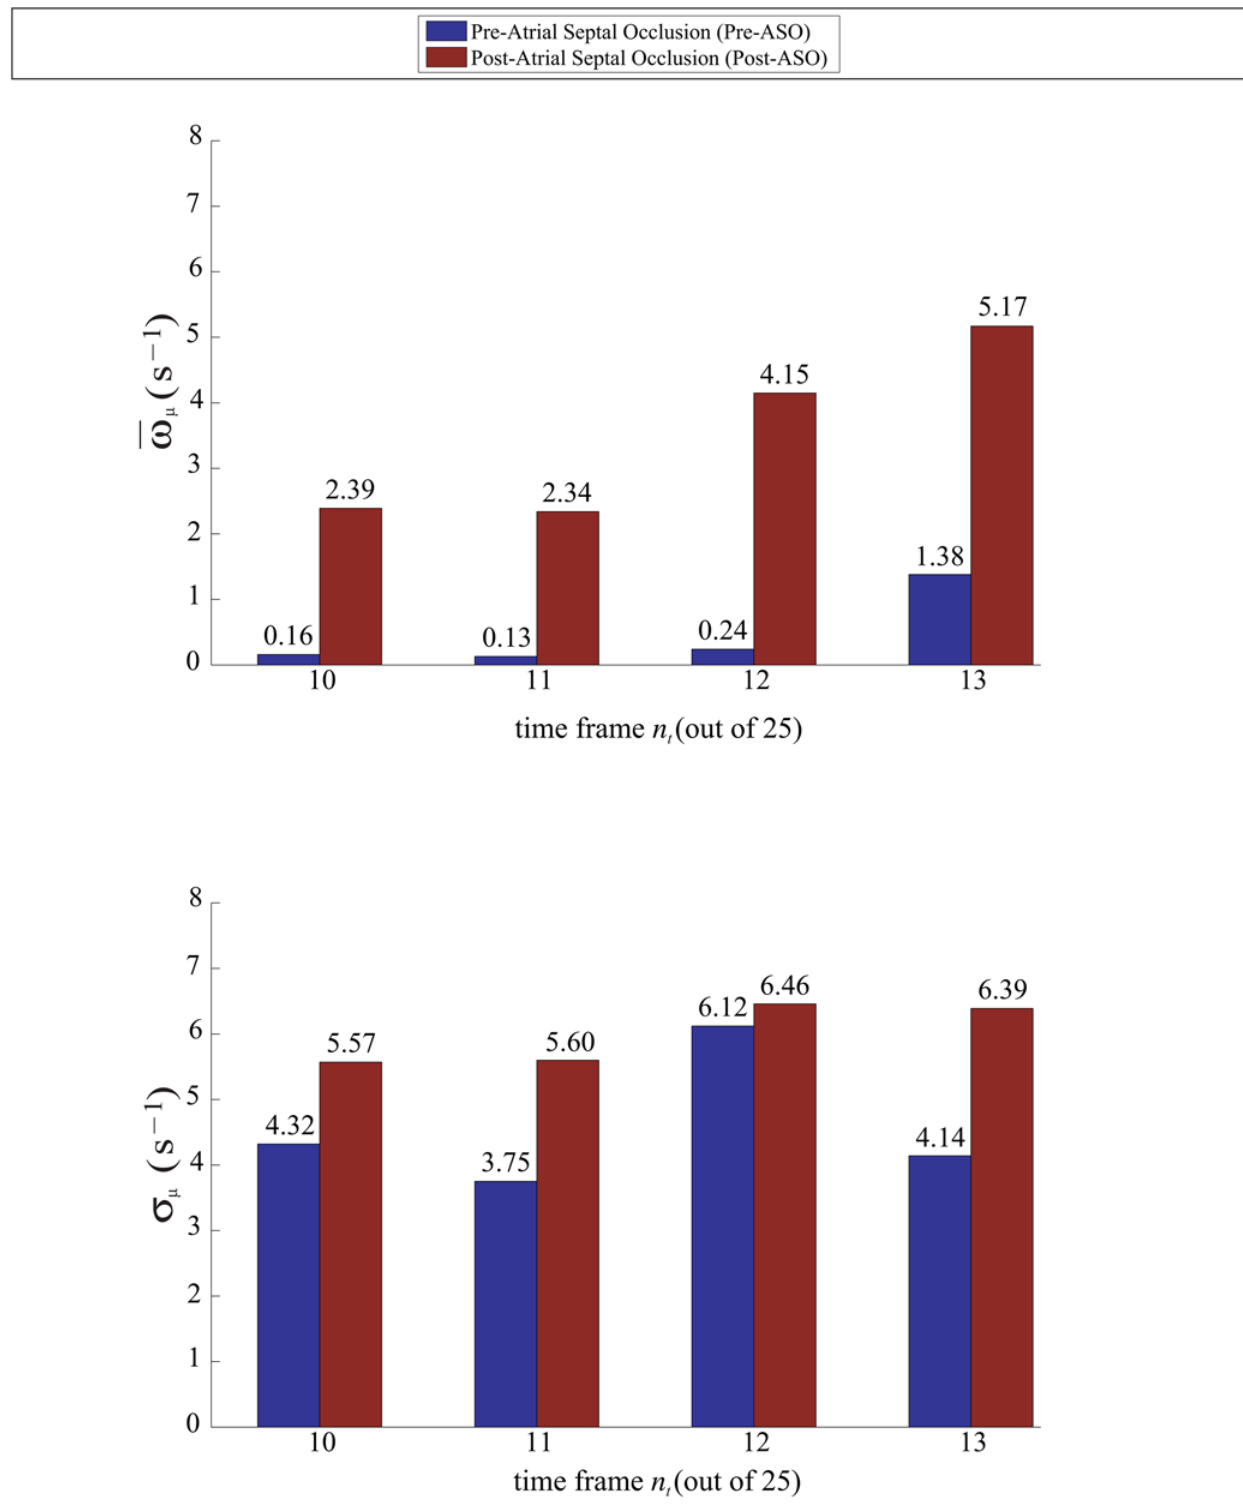
Figure 6. Time-variation of vorticity properties for pre- and post-ASO flow maps. The results show that there is a difference in pre- and post-ASD vorticity maps statistically. Parameters such as mean v¯ as well as standard deviations s are based on histograms of the vorticity maps pertaining to time frames n t =10 to 13 out of 25 frames in a cardiac cycle. Both averaging of means , v¯ . and of standard deviations , s . are shown to be higher for post-ASO vorticity flow maps.